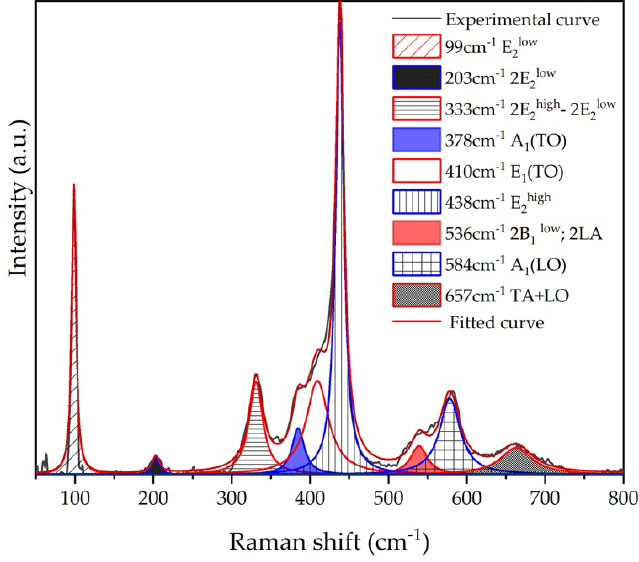
Figure 7. Raman spectrum of ZnO MSs with different localized vibrational modes.